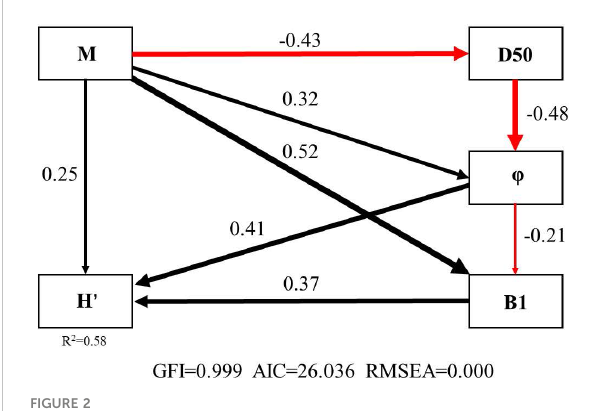
FIGURE 2 The SEM (Structural Equation Model) for Manila clam- H' (M 、 B1 、 j 、 D50 and H' represent the biomass of Manila clam, the biomass of functional group B1, water content, particle size and Shannon-Wiener diversity index of macrobenthic community, respectively. The black arrow indicates a positive effect, and the red one indicates a negative effect).